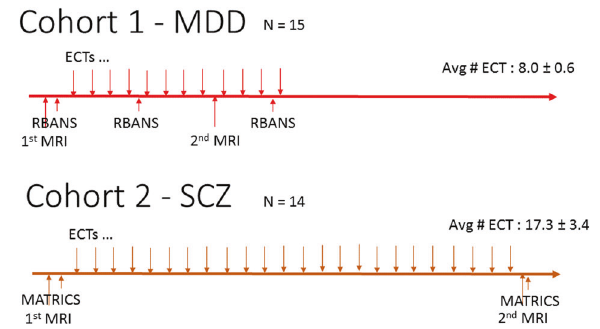
Fig. 1 Study design. a Cohort 1 — MDD ( N = 15). b Cohort 2 — SCZ ( N =